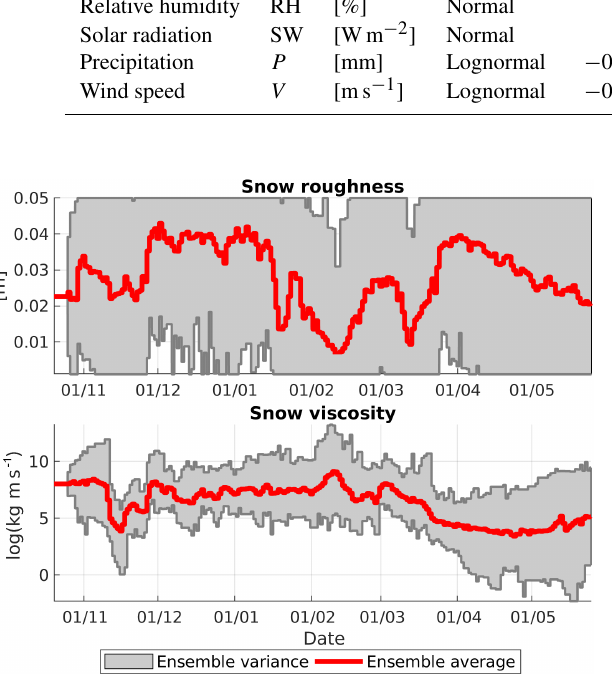
Figure 3. Uncertainty of model parameters: CDP site, winter 2010/2011. The panel shows the ensemble seasonality of snow roughness and snow